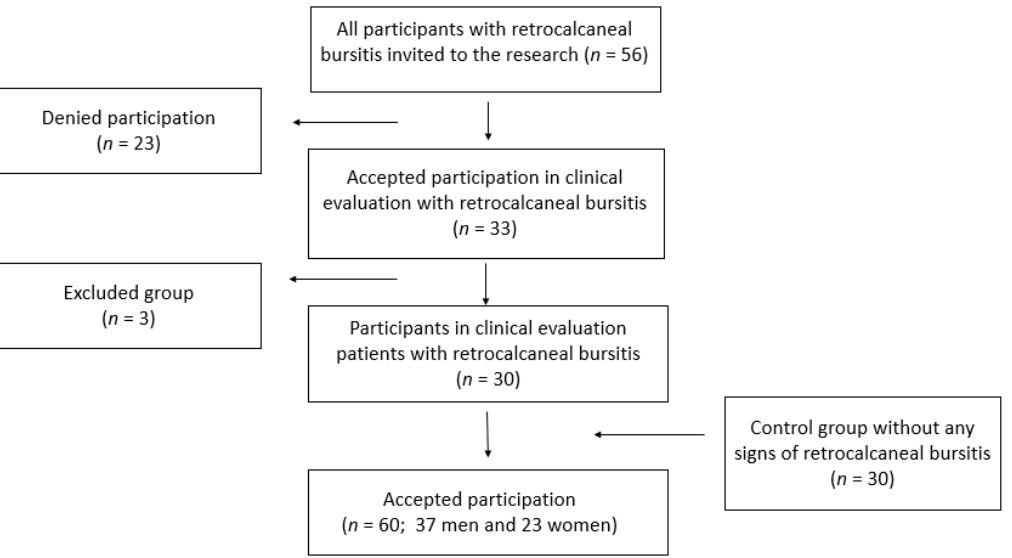
Figure 1. Flow-chart of participant recruitment.